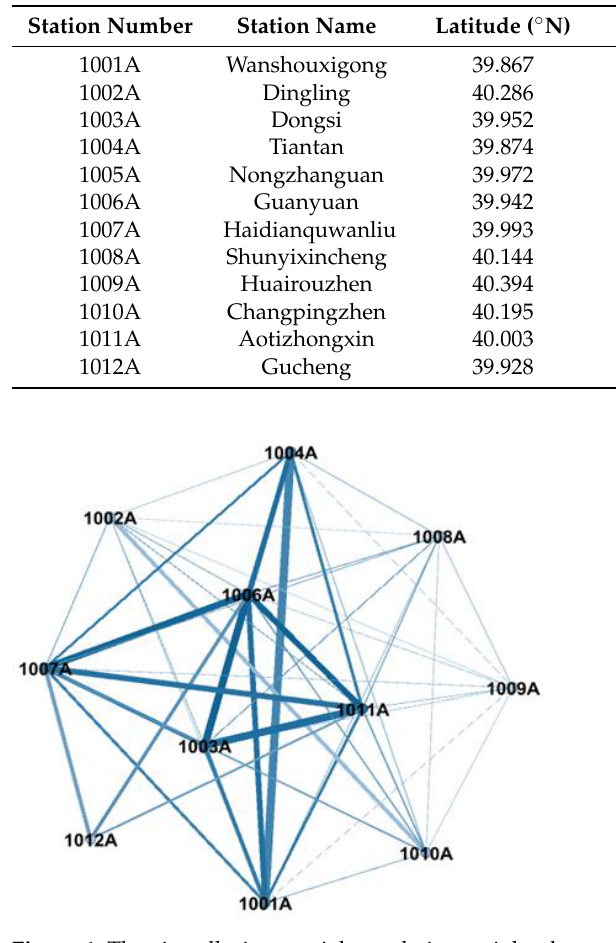
Table 4. Ranking of influential nodes in the air pollution spatial correlation weighted network of Beijing.